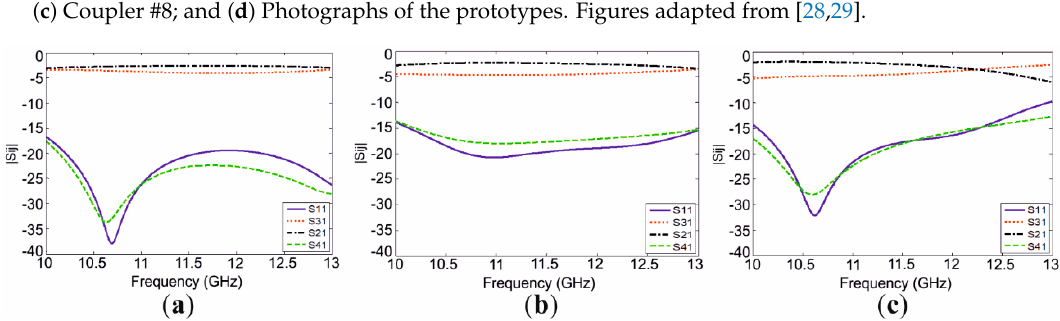
Figure 3. Experimental responses for the couplers shown in Figure 2 [29]. ( a ) Coupler #6; ( b ) Coupler #7; and ( c ) Coupler #8. Figures adapted from [28,29].